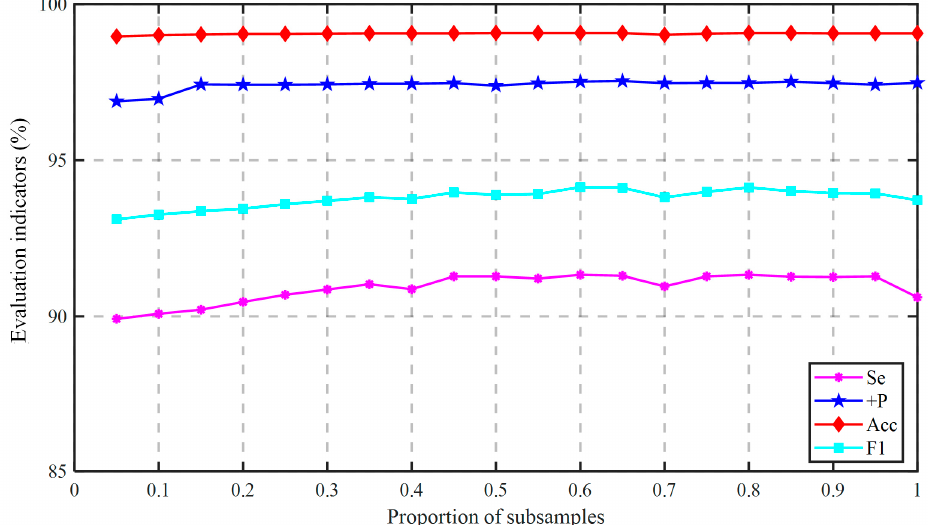
Figure A4. The performance change with the “subsample”.